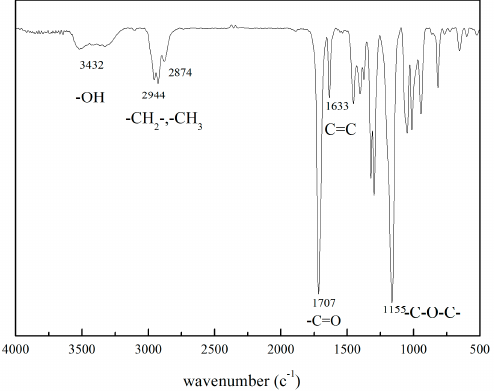
Figure 1. Fourier transform infra-red (FTIR) spectra of the initiator HSEMA.